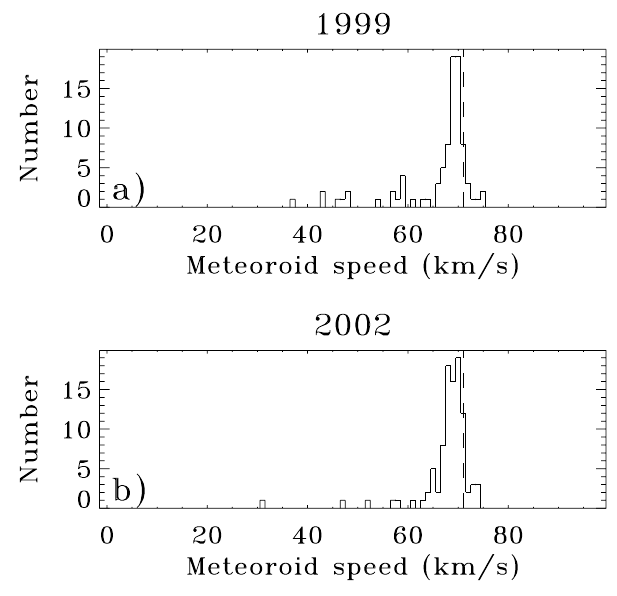
Fig. 6. Examples of meteoroid speeds estimated using all echoes with right ascension (RA) and declination (DEC) within ± 2 ◦ of the accepted Leonid radiant ( 153 ◦ , 22 ◦ ) using all-sky interferomet- ric meteor radars located at (a) Juliusruh, Germany, 1999, and (b) Andenes, Norway, 2002. The dashed line indicates the theoreti- cal pre-atmospheric entrance speed of Leonid shower meteoroids (71kms − 1